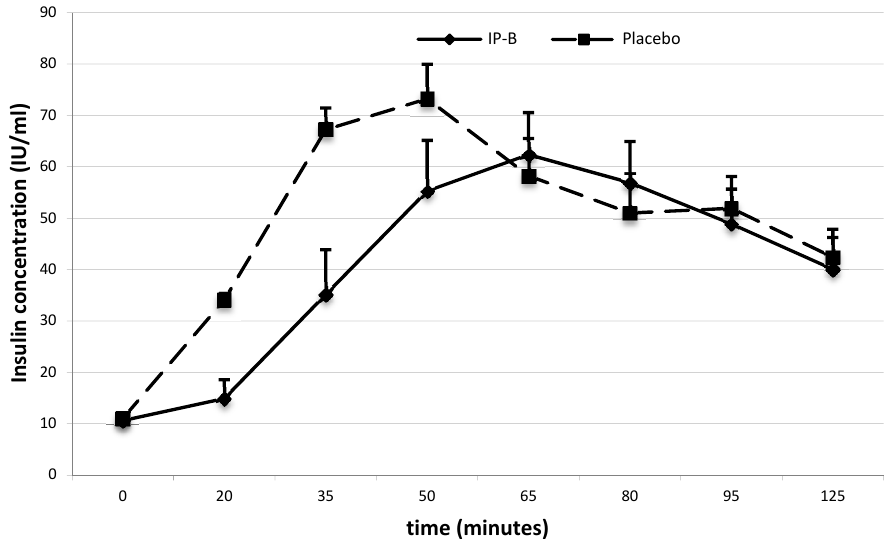
Figure 4. Average insulin concentration (IU/mL) after ingestion of the Investigational Product (IP) B vs. the placebo.